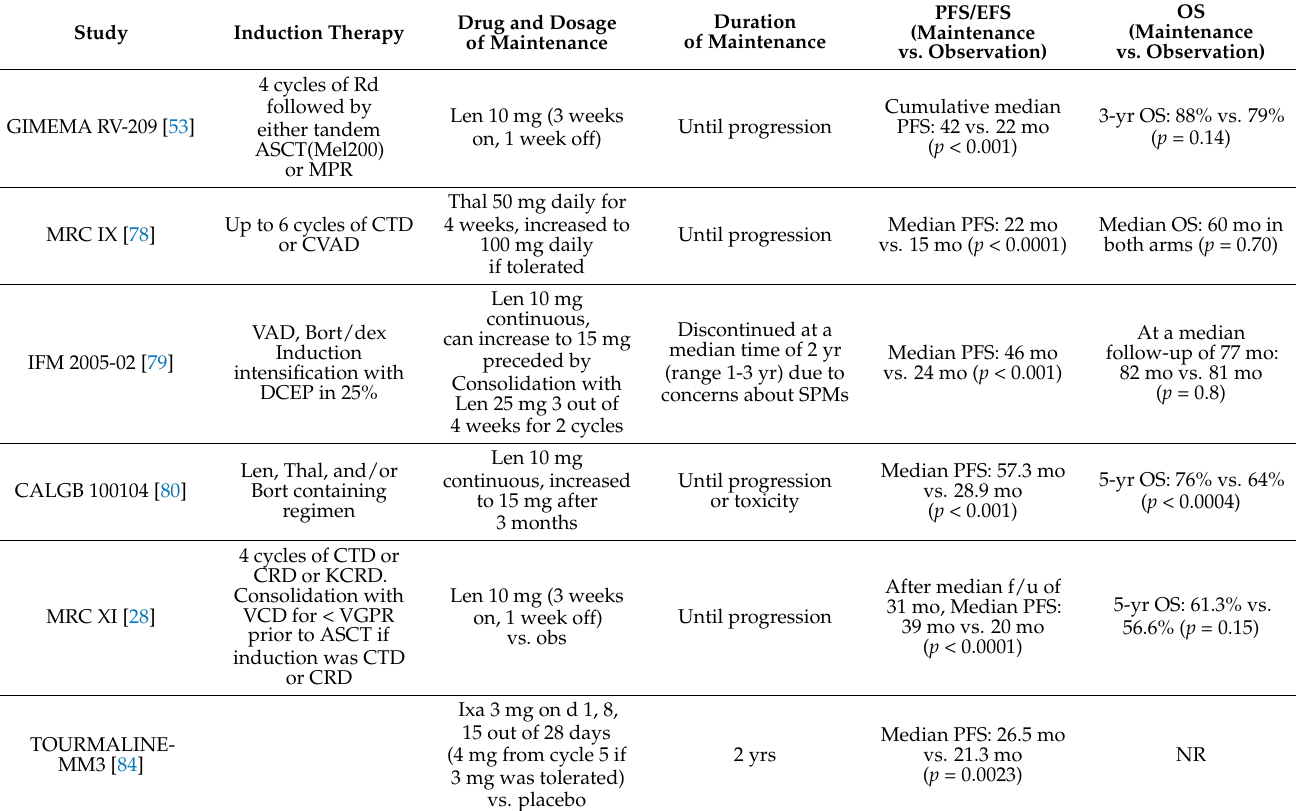
Table 3. Randomized studies done in post-ASCT maintenance